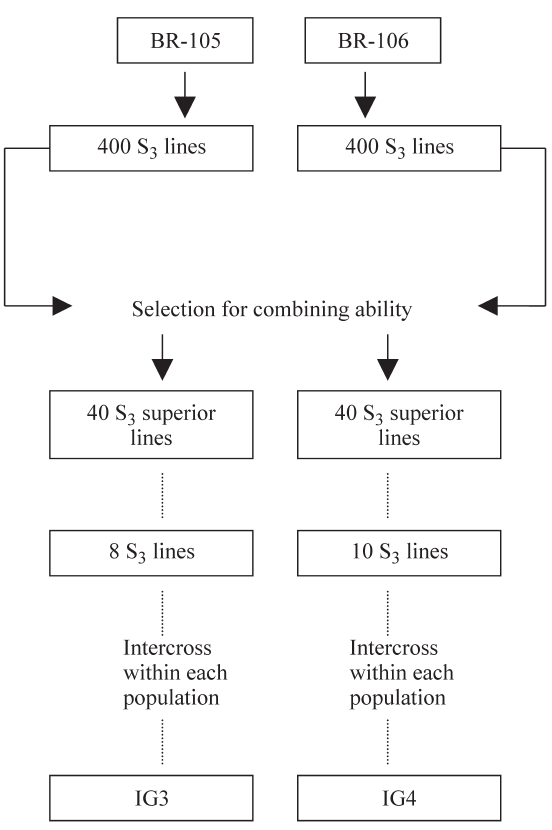
Figure 1 - Description of the modified RRS in which a high-intensity of selection was applied to BR-105 and BR-106 giving rise to the synthetics IG3 and